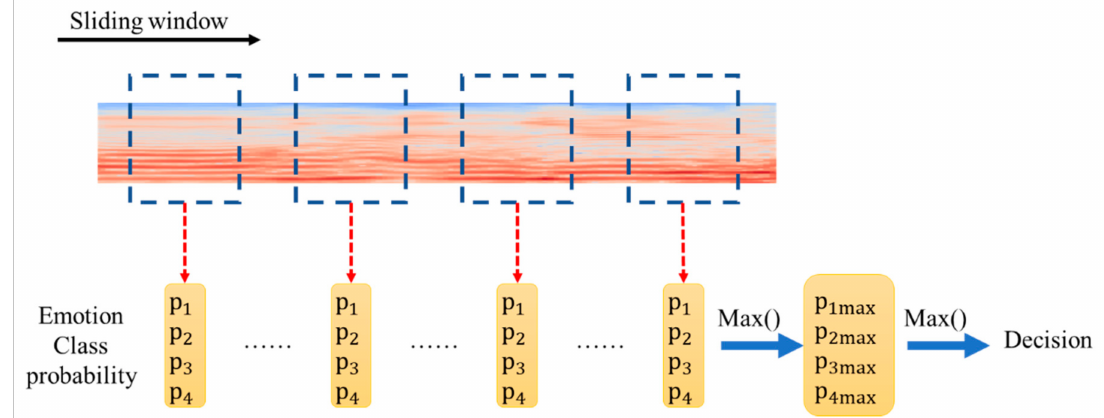
Figure 6. Overall architecture of decision process of emotion prediction, the highest score of all the utterance is decided as the final output emotion class.